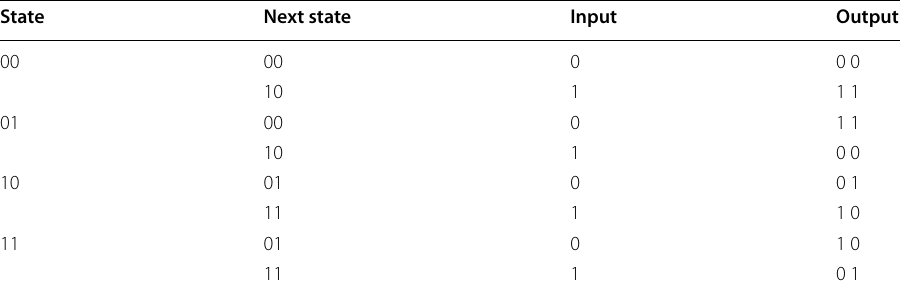
Table 3 State transition description of the code ( 57 )